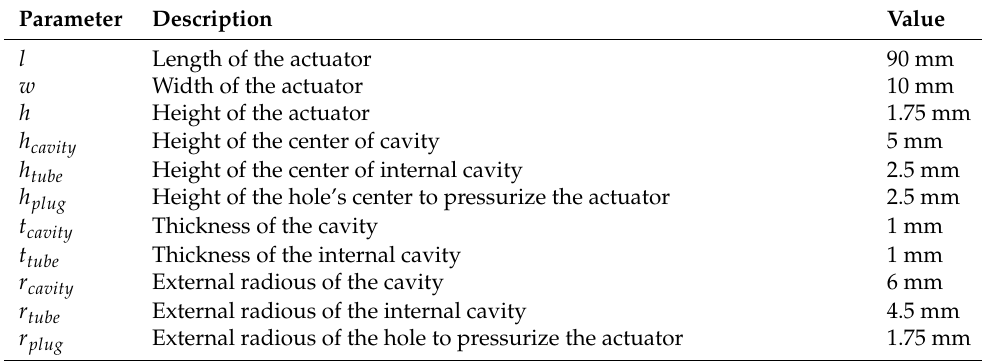
Table 1. Selection of parameters for the soft actuator detailed in Figure 2.